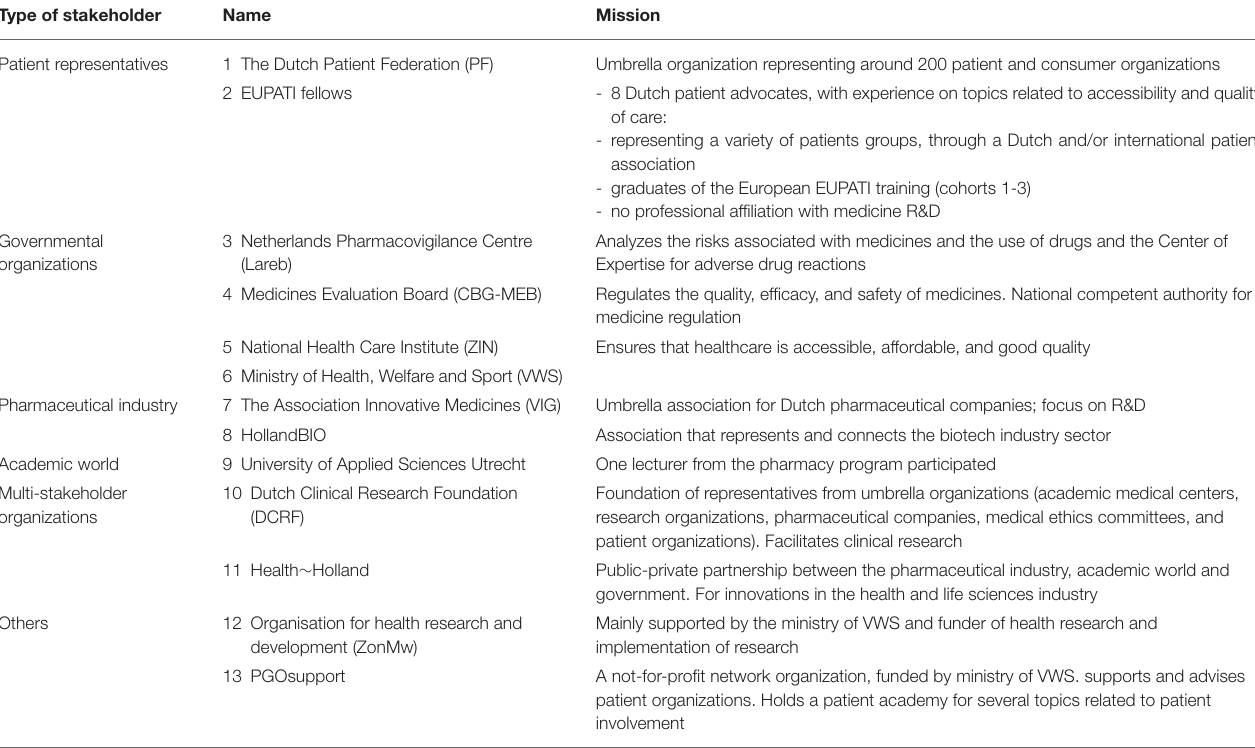
TABLE 1 | Organizations involved in the interviews and the mission of the organizations. Type of